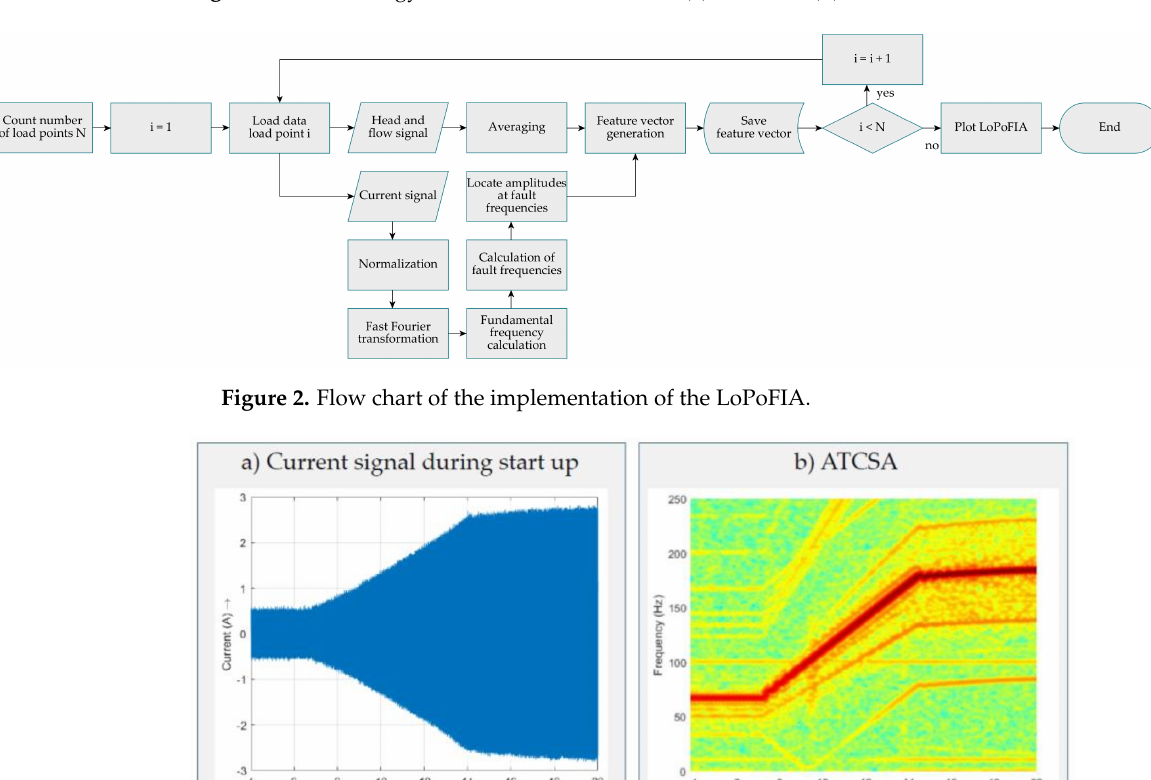
Figure 1. Methodology of feature extraction from ( a ) MCSA to ( b ) LoPoFIA.